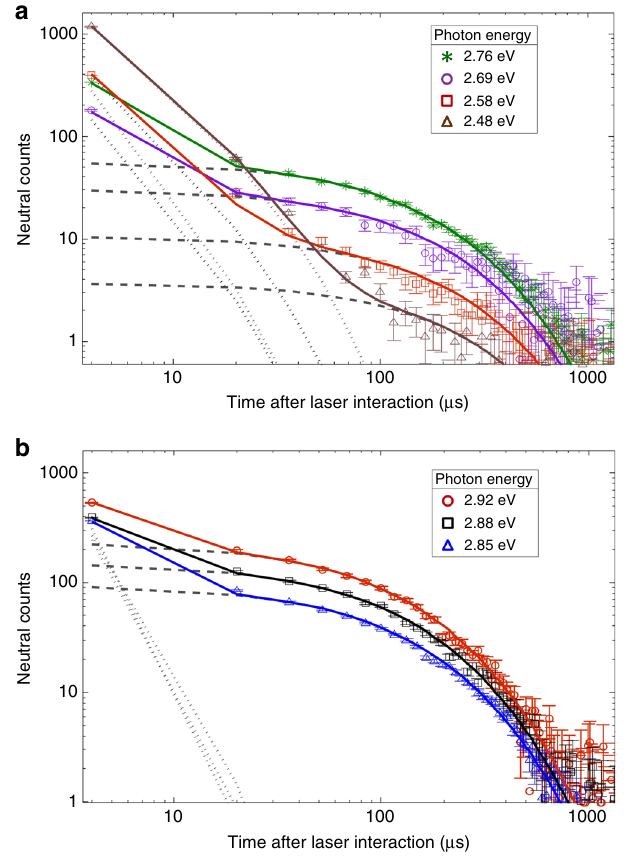
Fig. 4 Normalized neutral counts as a function of time after laser interaction with C (cid:1) . a Photoexcitation energies from below to just above the 10 isomerization barrier, b photoexcitation energies well above the barrier. The results shown here for each photon energy were obtained by collecting data for ~10 5 trapping cycles. The zero of the time axis is the time of laser interaction. The contribution of neutrals produced due to residual gas collisions has been subtracted and the data normalized with respect to background and laser photon counts. The symbols are the experimental data. The error bars are the standard deviation of the experimental data. The lines are from theoretical calculations using the model. The dashed lines denote contributions from one-photon excitations while the dotted lines are due to excitations from two photons. The solid lines represent the contribution from both and agree well with the experimental